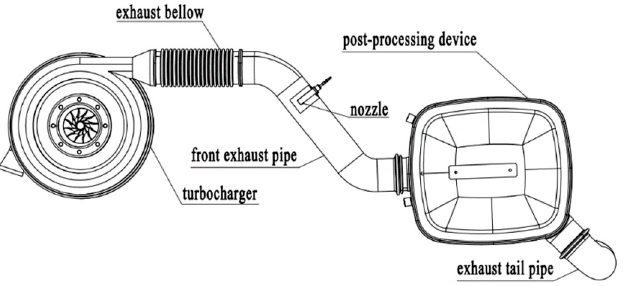
Figure 1. The sequence of the turbocharger, bellow, front exhaust pipe, nozzle and post-processing device.